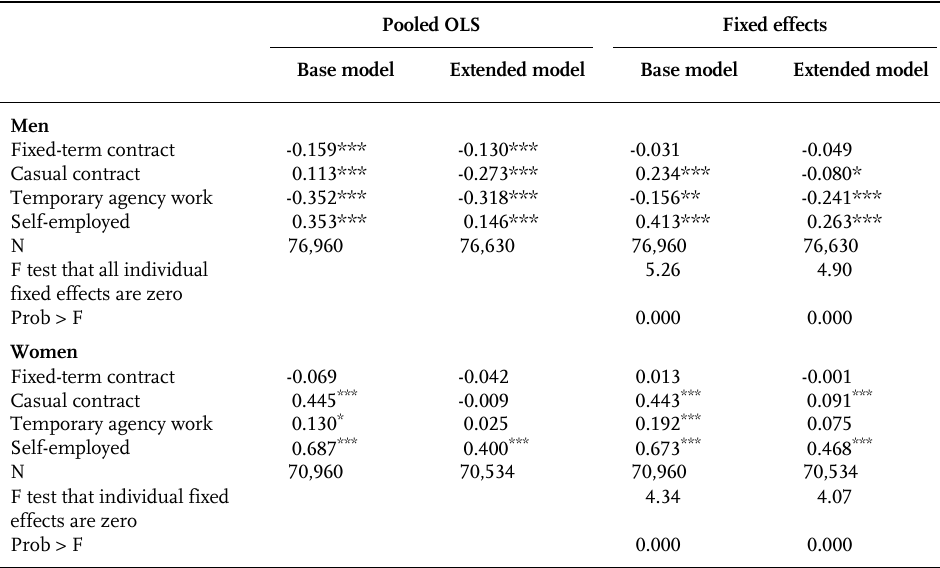
Table 3 : Employment type and WLB: Comparison of estimates from pooled OLS and fixed- effect